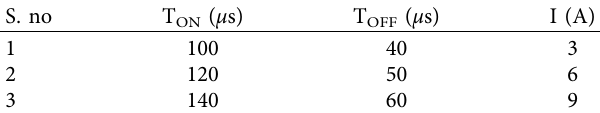
Table 1: Parameters and levels.